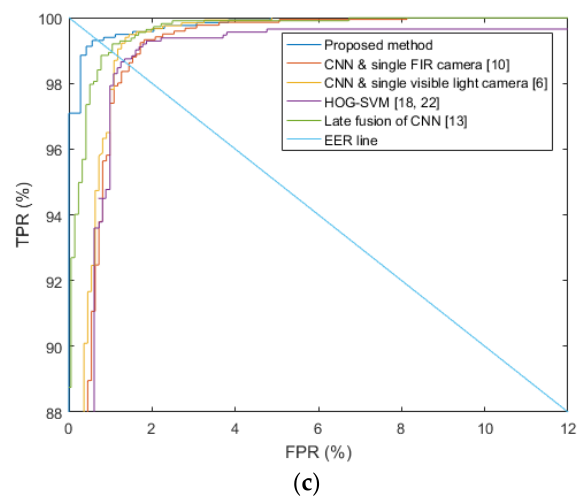
Figure 13. ROC curves with ( a ) original DVLFPD-DB1, ( b ) degraded DVLFPD-DB1, and ( c ) OSU color-thermal database.